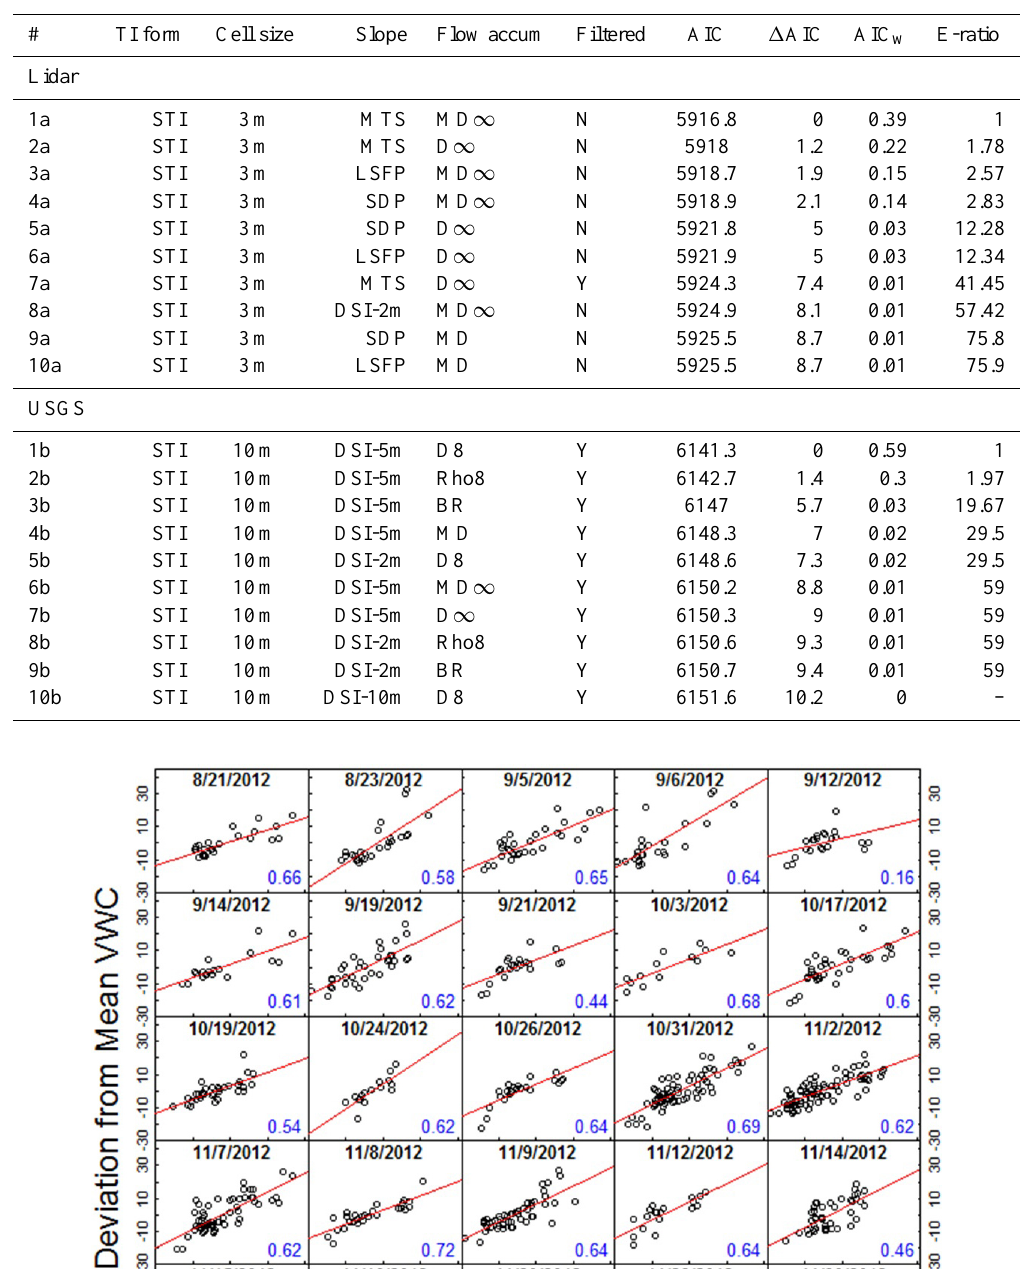
Table 5. Top 10 best-performing TWIs from the mixed effects analysis for the lidar and USGS data sets.